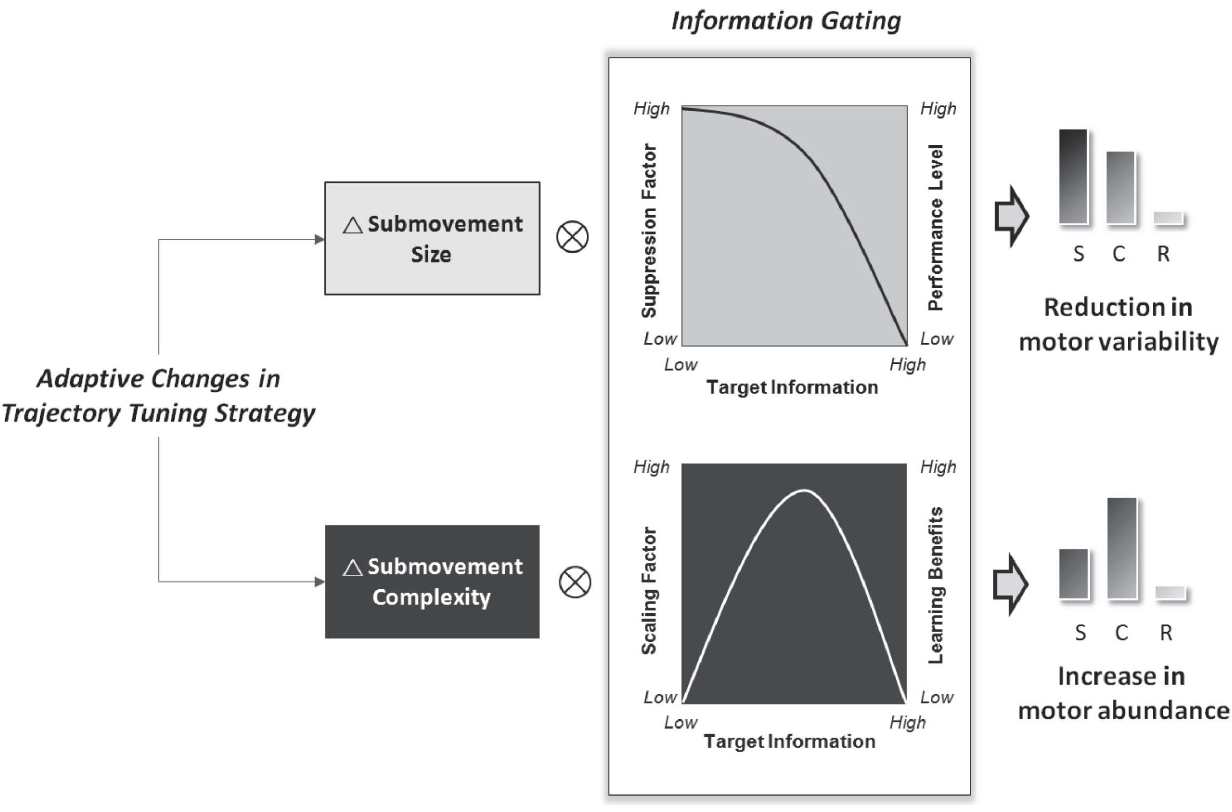
Figure 8. Summary illustration of learning-based channeling and modulation of submovement characteristics with respect to target information. The amounts of change in submovement size ( g submovement size) and submovement complexity ( g submovement complexity) are differently modulated with respect to target information. In accordance with the learning-information relationship, g submovement size is downward-modulated with target information increment (simple (S) . complex (C) . random (R)). Namely, submovement size is not suppressed under practice with excessive target information. On the other hand, the effect of target information on g submovement complexity during practice is an inverted-U function, with maximal change in complexity at medium target information.